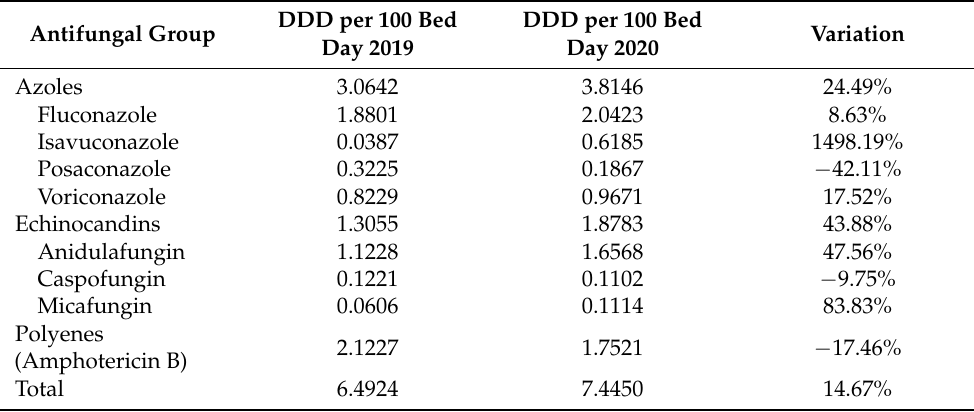
Table 2. Use of antifungals in 2019 and 2020 in the hospital.